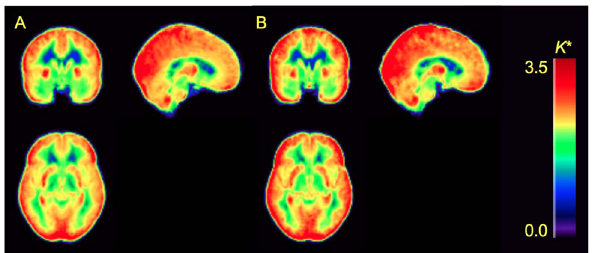
Figure 1. Parametric images of voxel-wise K* values for [1- 11 C]DHA. Images are group averages for controls (A; N=22) and alcoholics (B; N=15). Units are m L min 2 1 ml 2 1 and are shown on color scale.